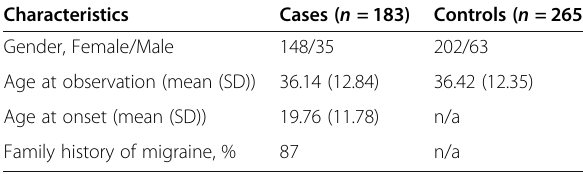
Table 2 Demographic and clinical data of patients with migraine and controls